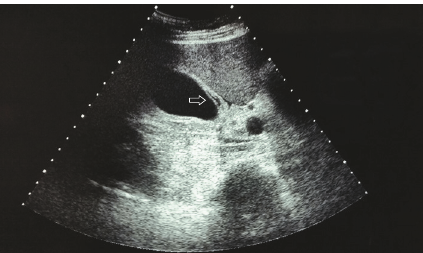
Figure 1: Ultrasound of the gallbladder, revealing thickened gall- bladder wall with a layered appearance